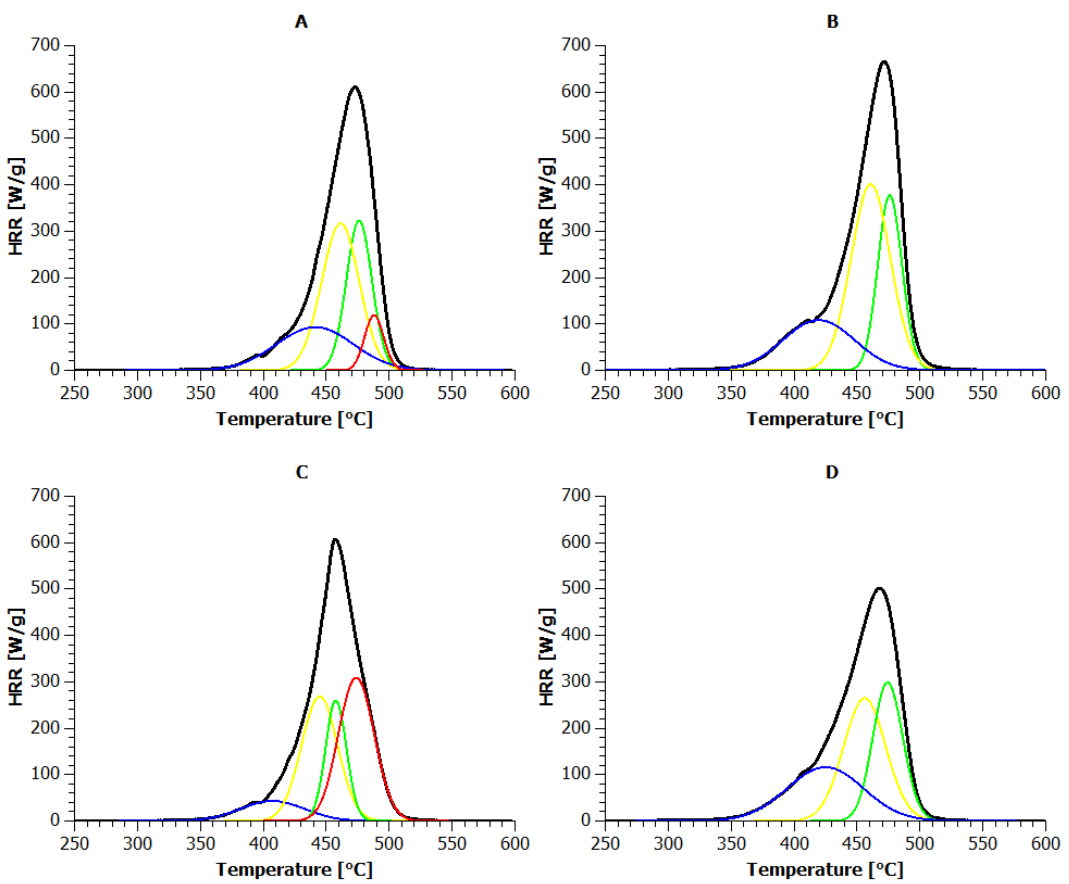
Figure 5. HRR = f (T) profiles and the deconvoluted curves from the primary data obtained using microcalorimetry for: ( A ) REF; ( B ) REFMMT; ( C ) 15L; and ( D ) 15LMMT.